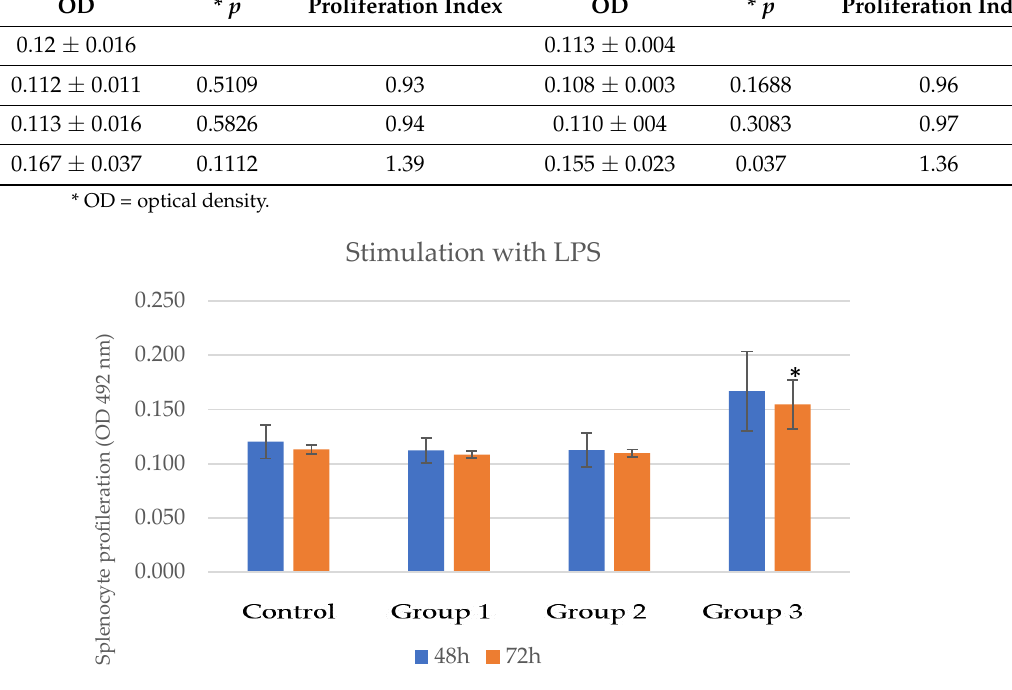
Figure 14. Lymphocyte proliferation capacity in groups that received the novel nutraceutical compared to the control group—stimulation with LPS; * = p value < 0.05.